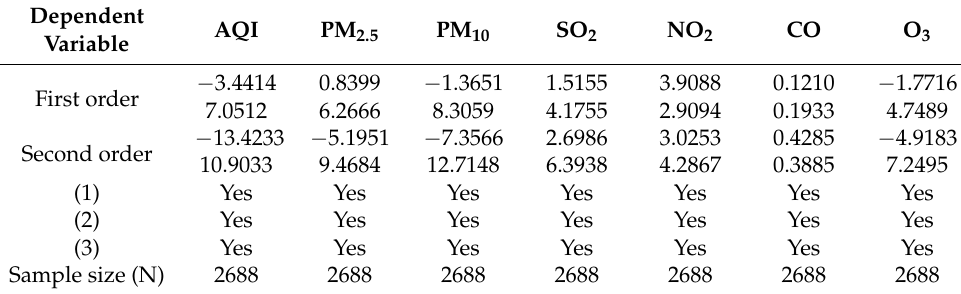
Table 9. Results of daily frequency RD estimation for the control group.